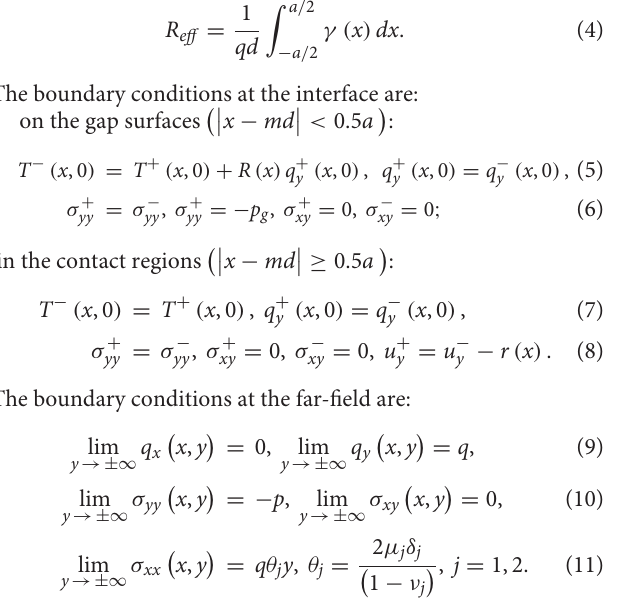
FIGURE 2 | The model of the contact.